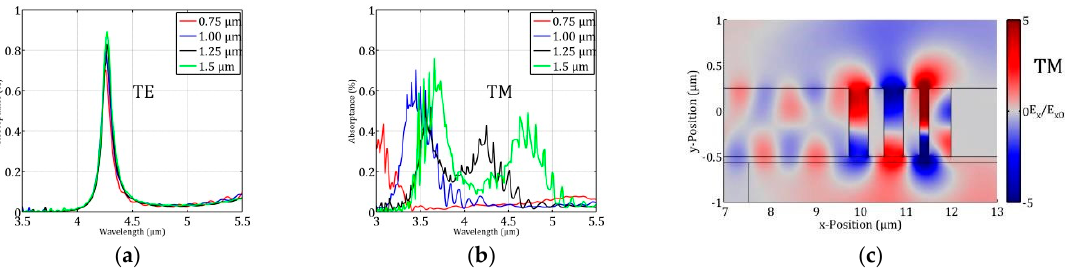
Figure 3. Absorbed fraction of incoming light by Ag of the slab TPP structure for TE ( a ) and TM ( b ) polarization. The broad peaks around 3.5 µm featured by the green, black and blue lines and the peak at 3 µm of the red line in ( b ) correspond to the TM-resonance featuring a similar electric field profile as in the TE case. ( c ) Odd (cid:1831) (cid:1876) mode profile at the TM resonance ( λ = 3.7 µm, (cid:1875) = 1.5